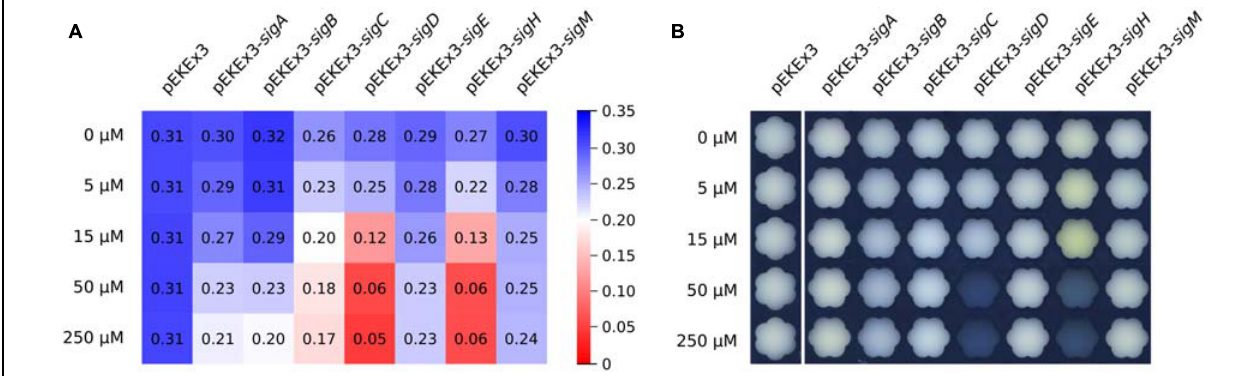
as growth medium. The different IPTG concentrations used to induce sigma factor gene overexpression are indicated. The growth rates (h − 1 ) depicted in (A) are color-coded from red to blue according to the given